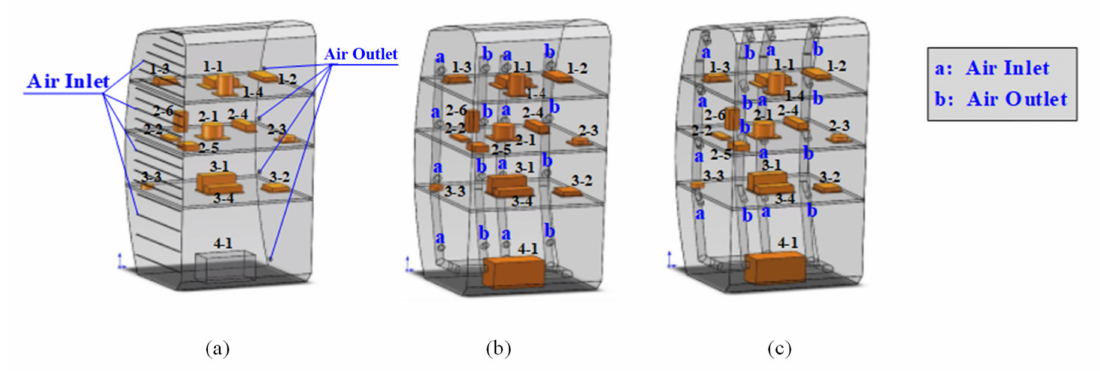
Figure 4. Geometric model. ( a ) Geometric model of new air cooling system; ( b ) Geometric model of traditional 120 ◦ lower air supply; ( c ) Geometric model of traditional 45 ◦ upper air supply.